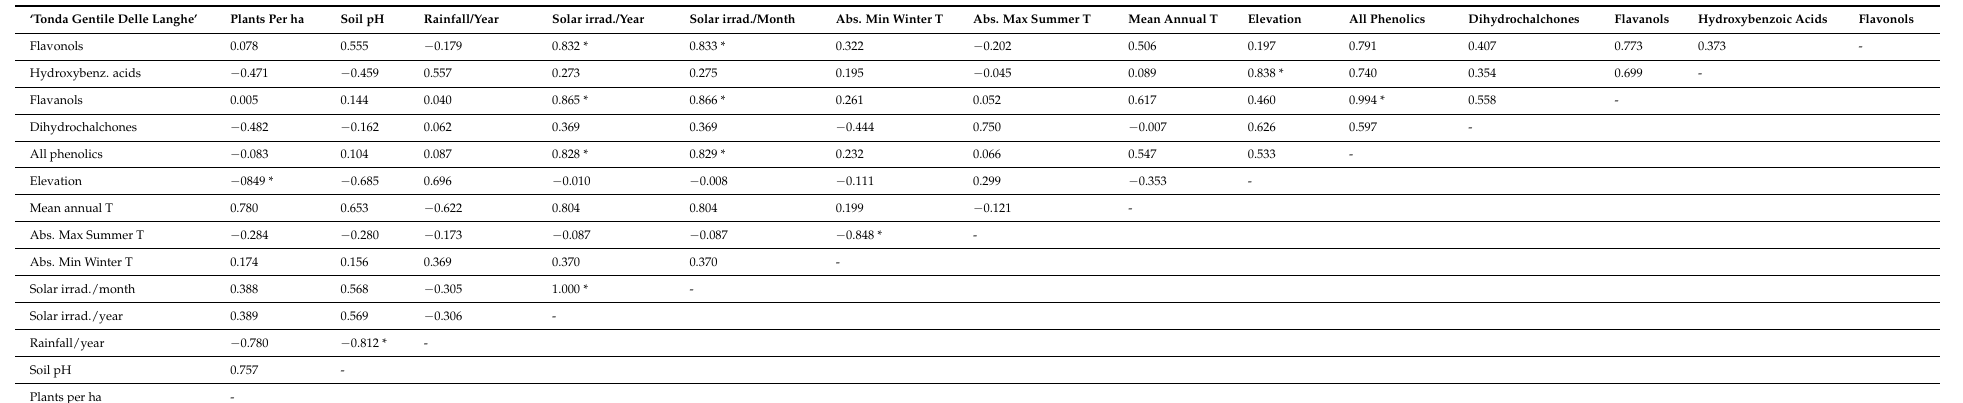
Table 4. Correlation table of the variables for the cultivar ‘Tonda gentile delle